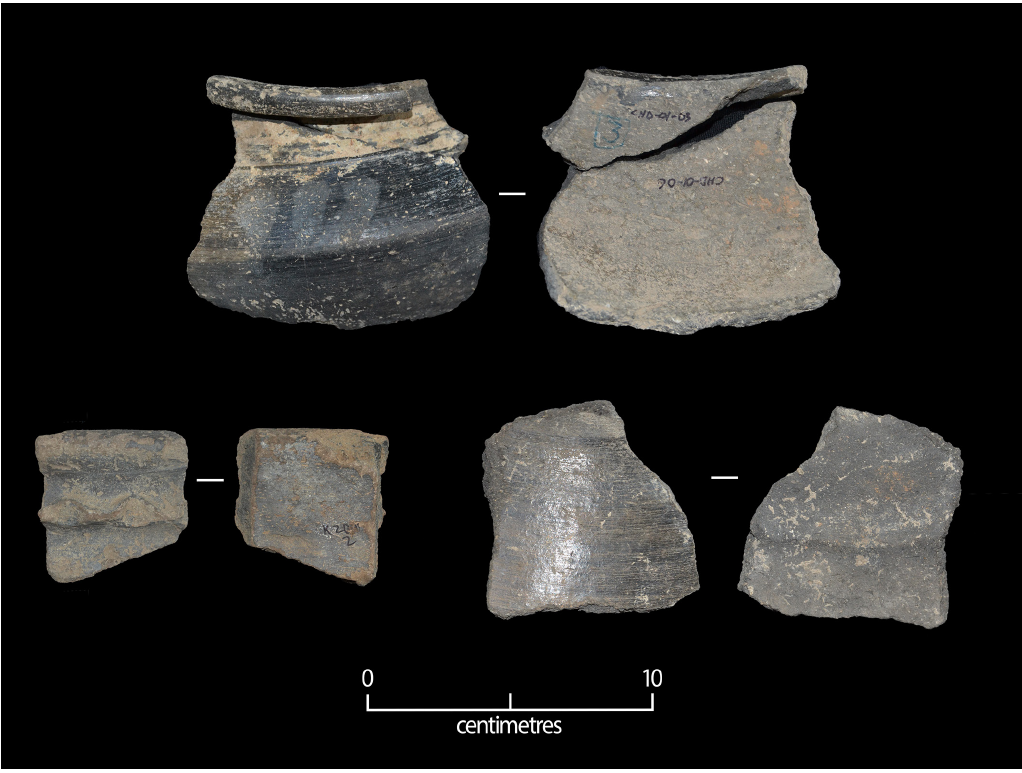
Figure 39: External and internal surfaces of Class 14 variant 4